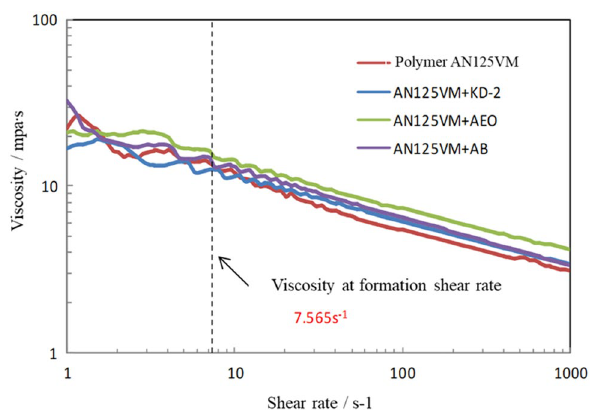
Fig. 5 Viscosity of surfactant-polymer mixture and polymer 125VM